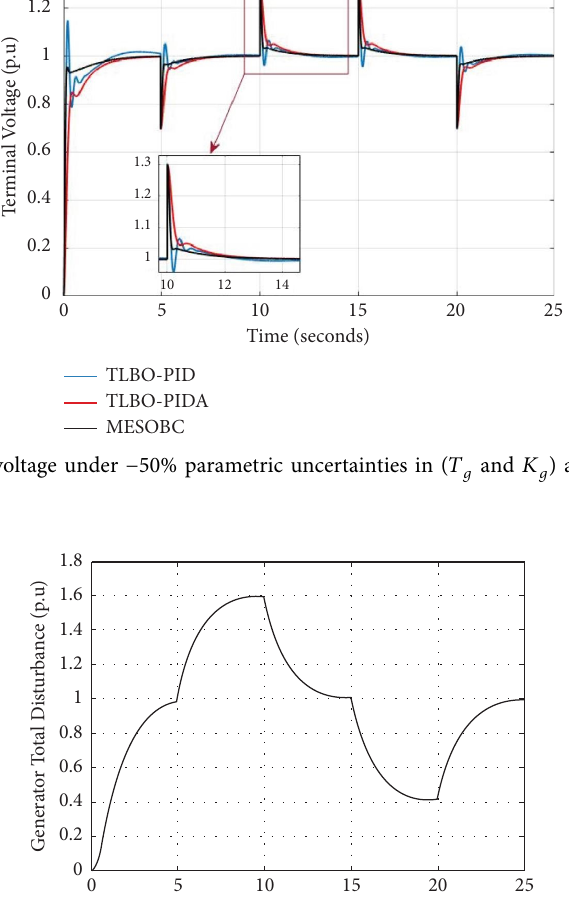
K g and g ) and ± 30% load voltage variation.